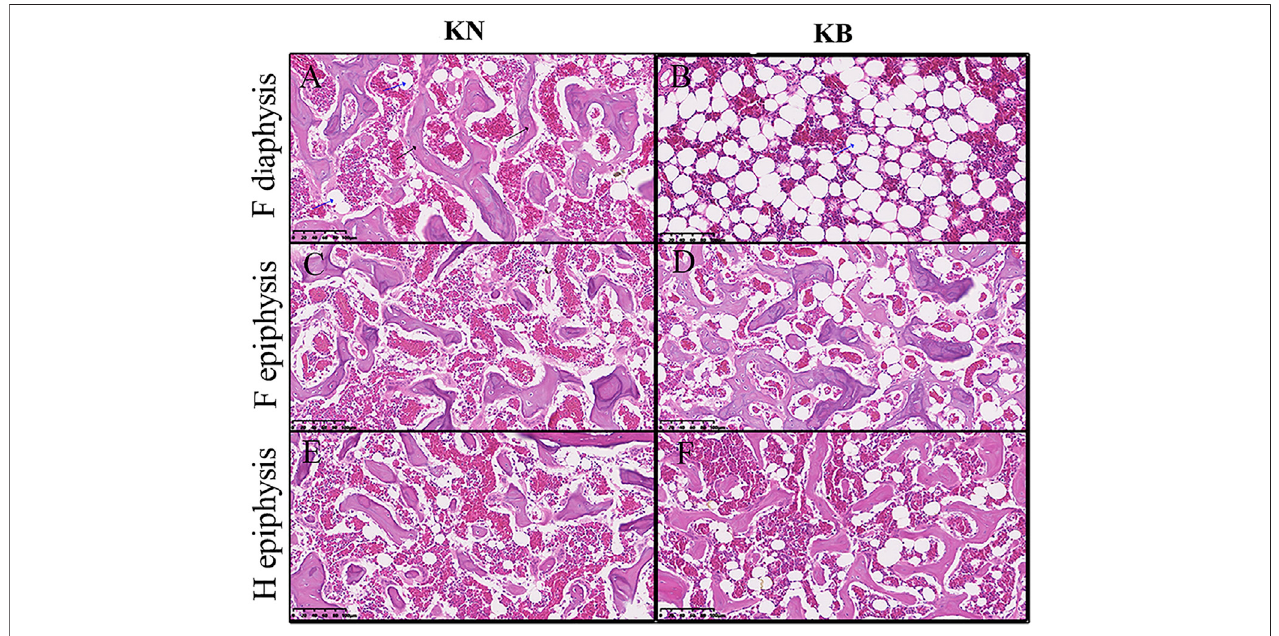
FIGURE5| BoneslicechartofthehumerusandfemurinKNandKBchickengroups.F,femur;H,humerus (AandB) Femurdiaphysis (CandD) femurepiphysis, and (E and F) humerus epiphysis. The black arrow indicates the bone trabecular structure. The blue arrow (vacuolated) indicates the adipose tissue.